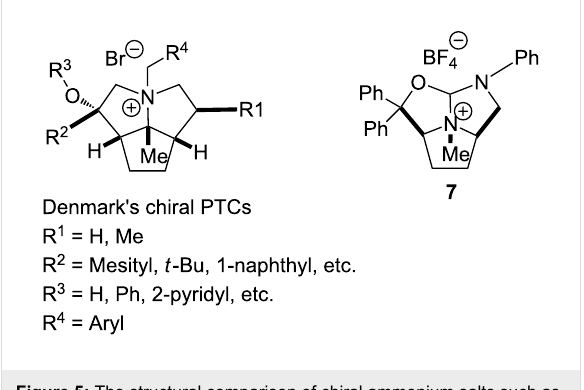
Figure 5: The structural comparison of chiral ammonium salts such as 7 with the chiral PTCs of Denmark et al.